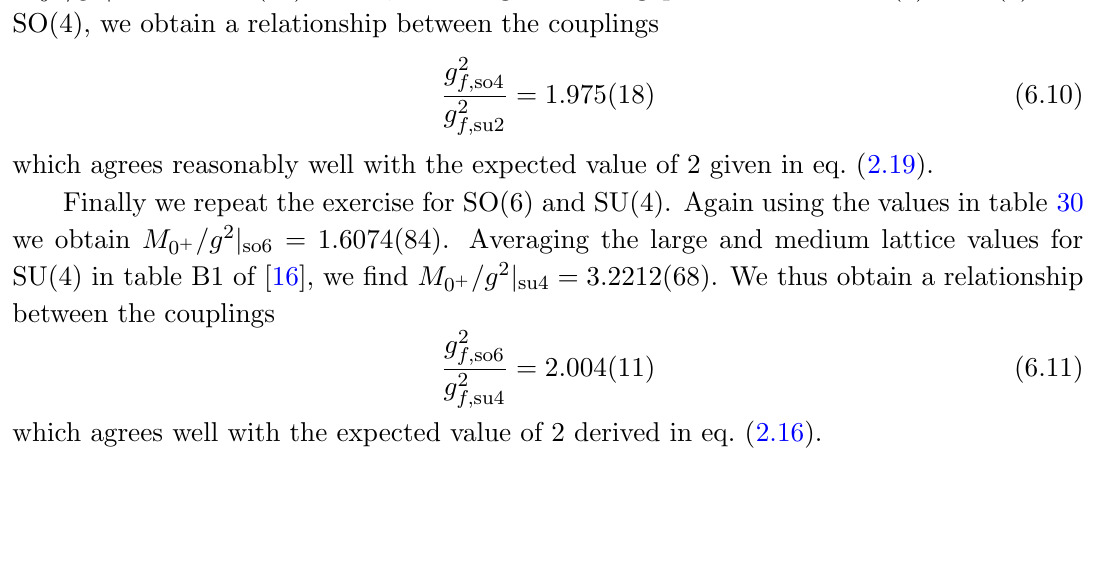
Figure 27 . Di(cid:11)erence between value of M ratio. Open points are N odd, (cid:12)lled points are N